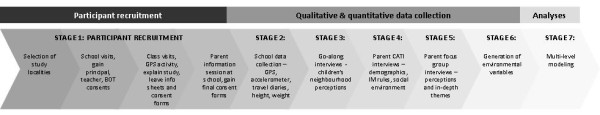
Diagram of the stages taken to participant recruitment and data collection in the Kids in the City study. Notes: BOT = School Board of Trustees, CATI = Computer Aided Telephone Interview, GPS = Global Positioning System, IM = independent mobility.